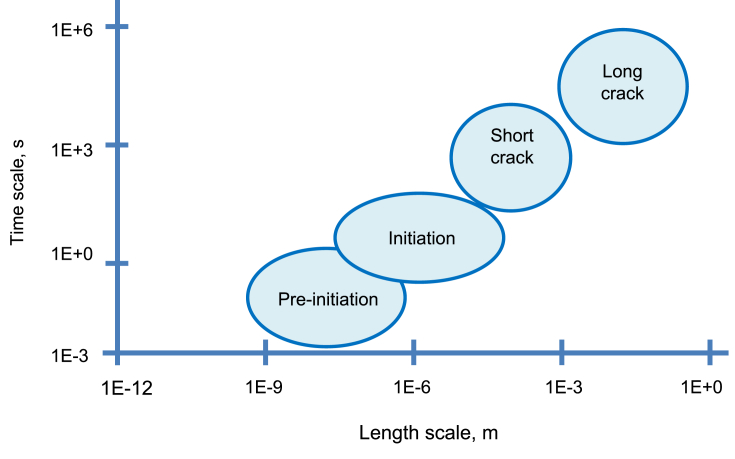
Representation of EAC/SCC stages according to approximate length- and time-scales.